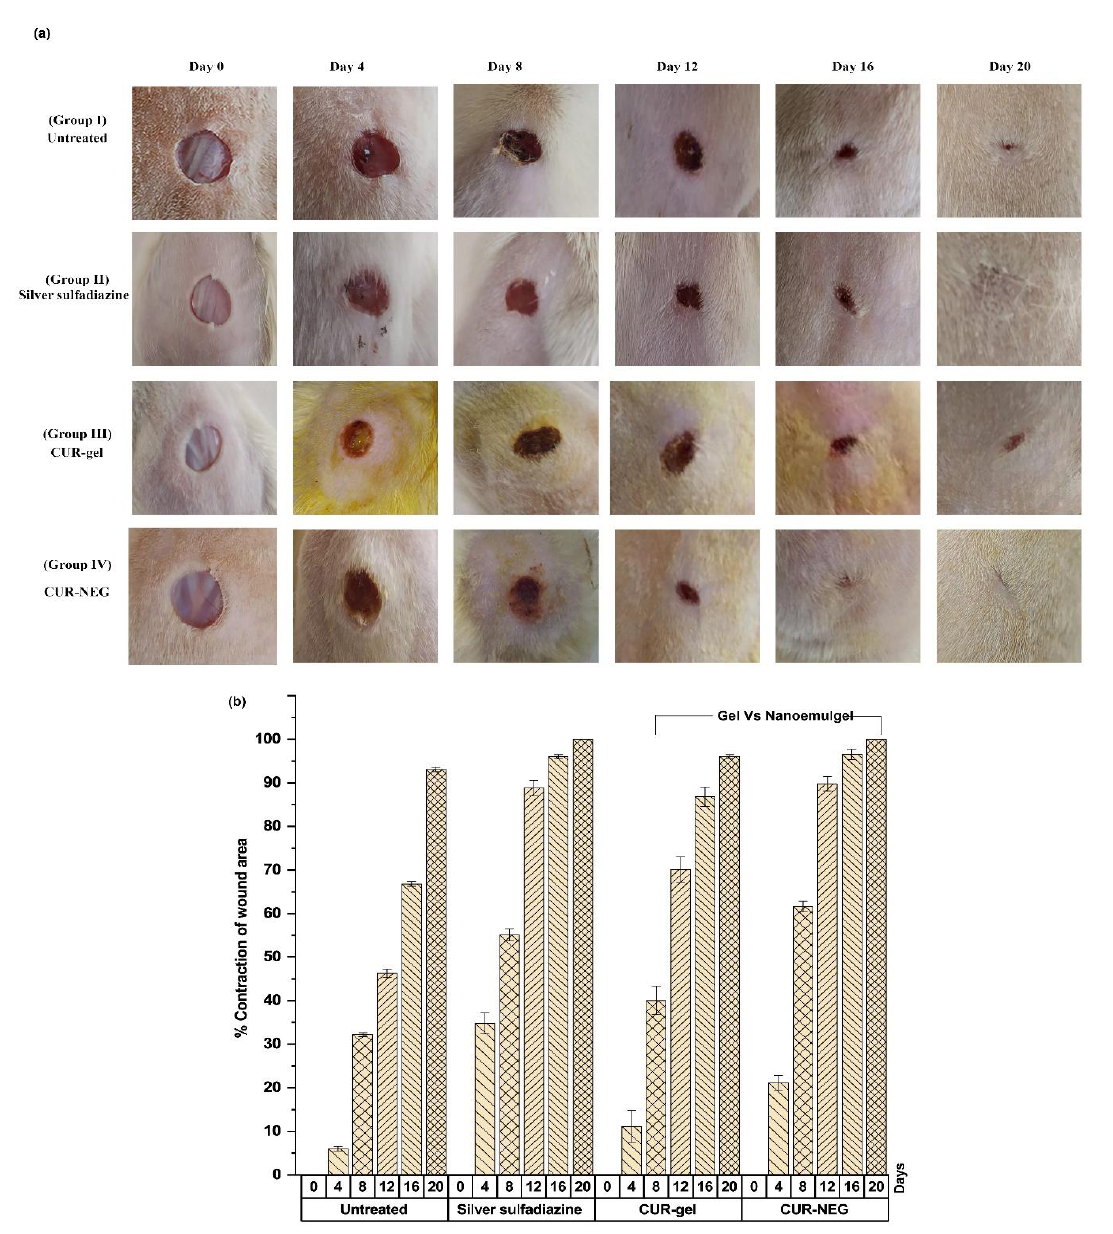
Figure 4. ( a ) In-vivo wound healing activity in Wistar rats ( b ) percentage contraction of wound area as an evaluation parameter for wound healing activity. Four groups were studied, Group I is the untreated group, Group II was treated with silver sulfadiazine cream, Group III was treated with the conventional curcumin gel (CUR-gel), and Group IV was treated with the curcumin NEG (CUR-NEG). Shaded bars represent the day number. Furthermore, the histopathological evaluation was performed to record the inflam- mation, collagen formation, and growth of the epithelial membrane. For this purpose, the